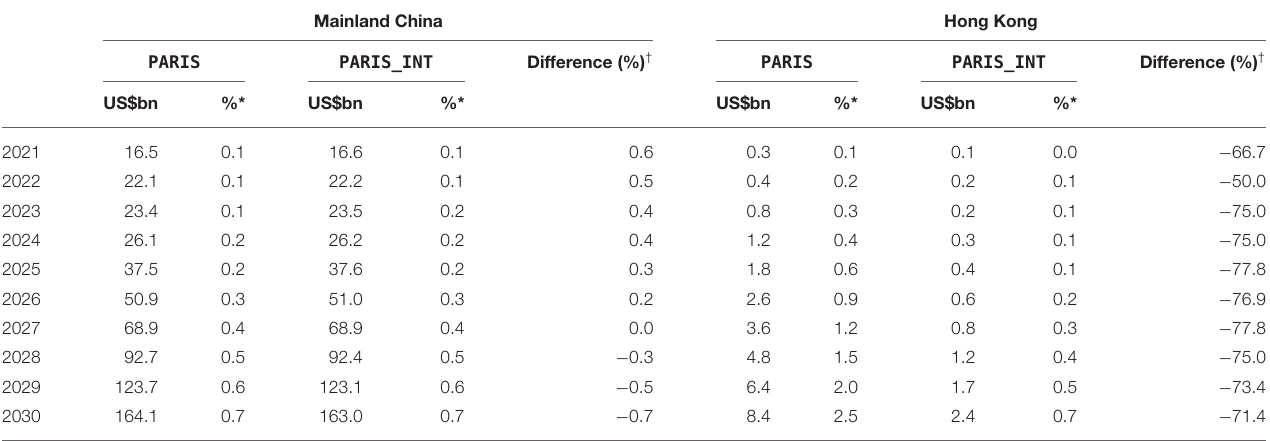
TABLE 4 | GDP loss under moderate mitigation targets (vs. BAU levels).